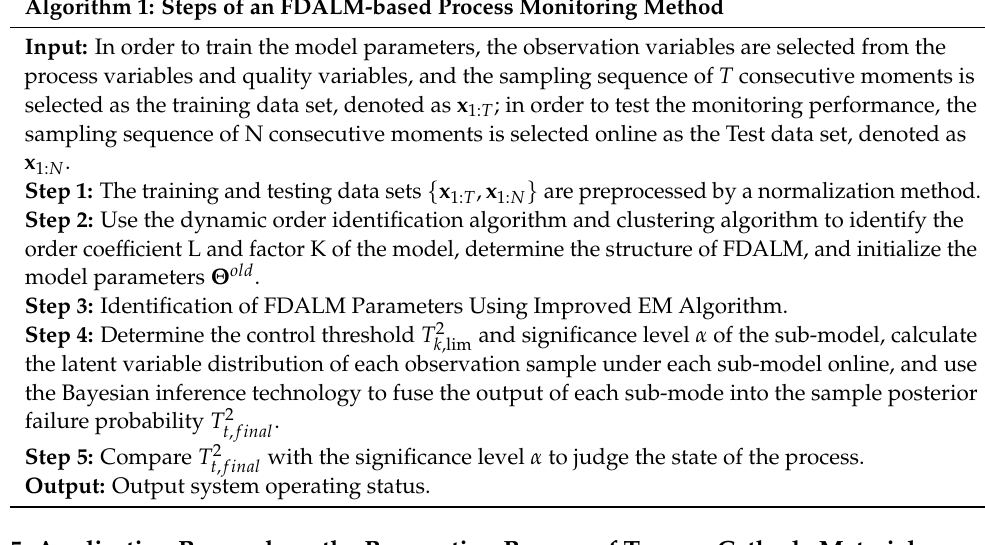
Algorithm 1: Steps of an FDALM-based Process Monitoring